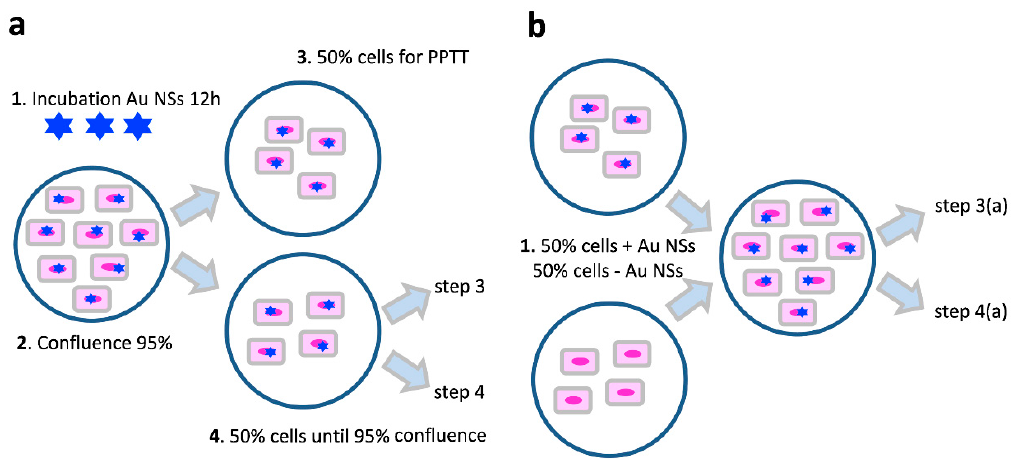
Figure 2. ( a ) Approach one: 1. Incubation of Au NSs for 12 h with uveal melanoma cells. 2. When the culture reached 95% confluence, the cells were divided in two different stocks. 3. The first stock with 50% of the cells was used for laser experiments. 4. The second stock with the other 50% of the cells was left in culture until 95% confluence, at which point it was again divided in two equal stocks to repeat the process. ( b ) Fresh cells and Au NS ‐ loaded cells (8 pM) were mixed at a 1:1 ratio (i.e., Au NS effective concentration of ~4 pM). When the culture reached 95% confluence, it was split in two as explained above (steps 3 and 4) and the process was repeated five times.